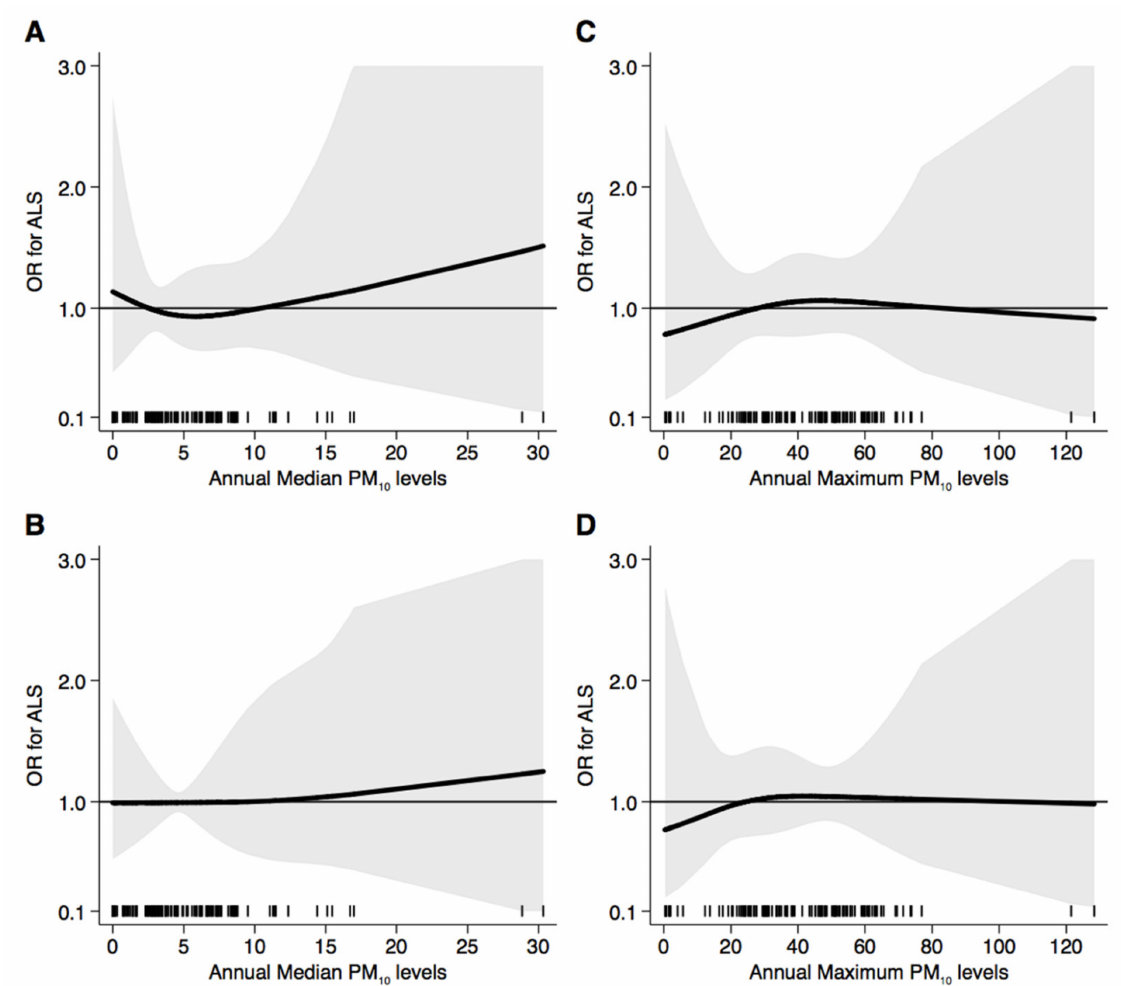
Figure 2. Spline regression analysis of amyotrophic lateral sclerosis (ALS) risk for increasing particulate matter (PM 10 ) exposure for both annual median and maximum levels using 10th, 50th, and 90th percentile distribution ( A , C ) or fixed categories (( B ): 5, 10, and 20 µ g/m 3 ; ( D ): 10, 20, and 50 µ g/m 3 ) as cutpoints. The black line indicates the odds ratio for ALS risk; the gray area indicates 95% confidence limits; the reference line is at 1.0; black spikes indicate the distribution of participant PM 10 level. Sensitivity analysis of subjects with stable residence within five years of